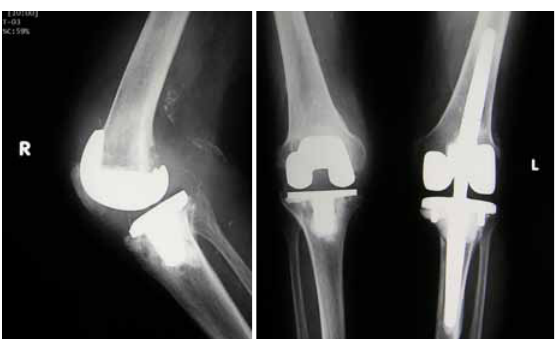
Figure 1a and 1b. Infected right knee prosthesis; left knee without